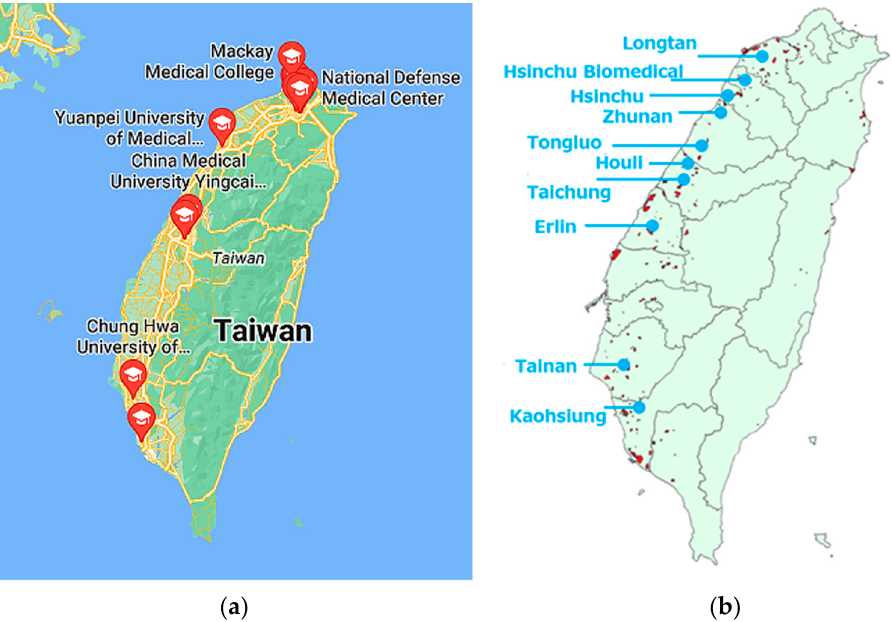
Figure 1. Distribution of ( a ) major medical institutes and ( b ) main science parks in Taiwan. Source ( a ) Google maps Source ( b ) Translated from site https://portal.stpi.narl.org.tw/index?p=article&id=4b1141427395c699017395c756b31f82 (accessed on 19 January 2023).